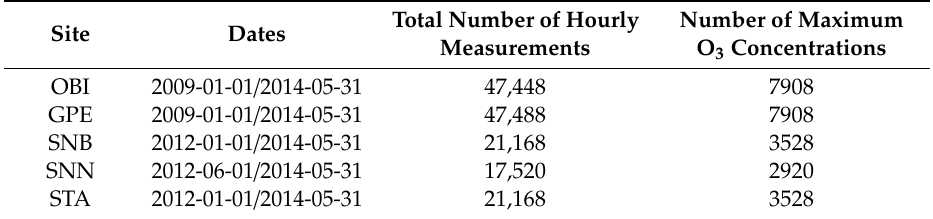
Table 4. Total number of hourly measurements per site and total number of maximum O 3 concentrations per time of day being modeled.